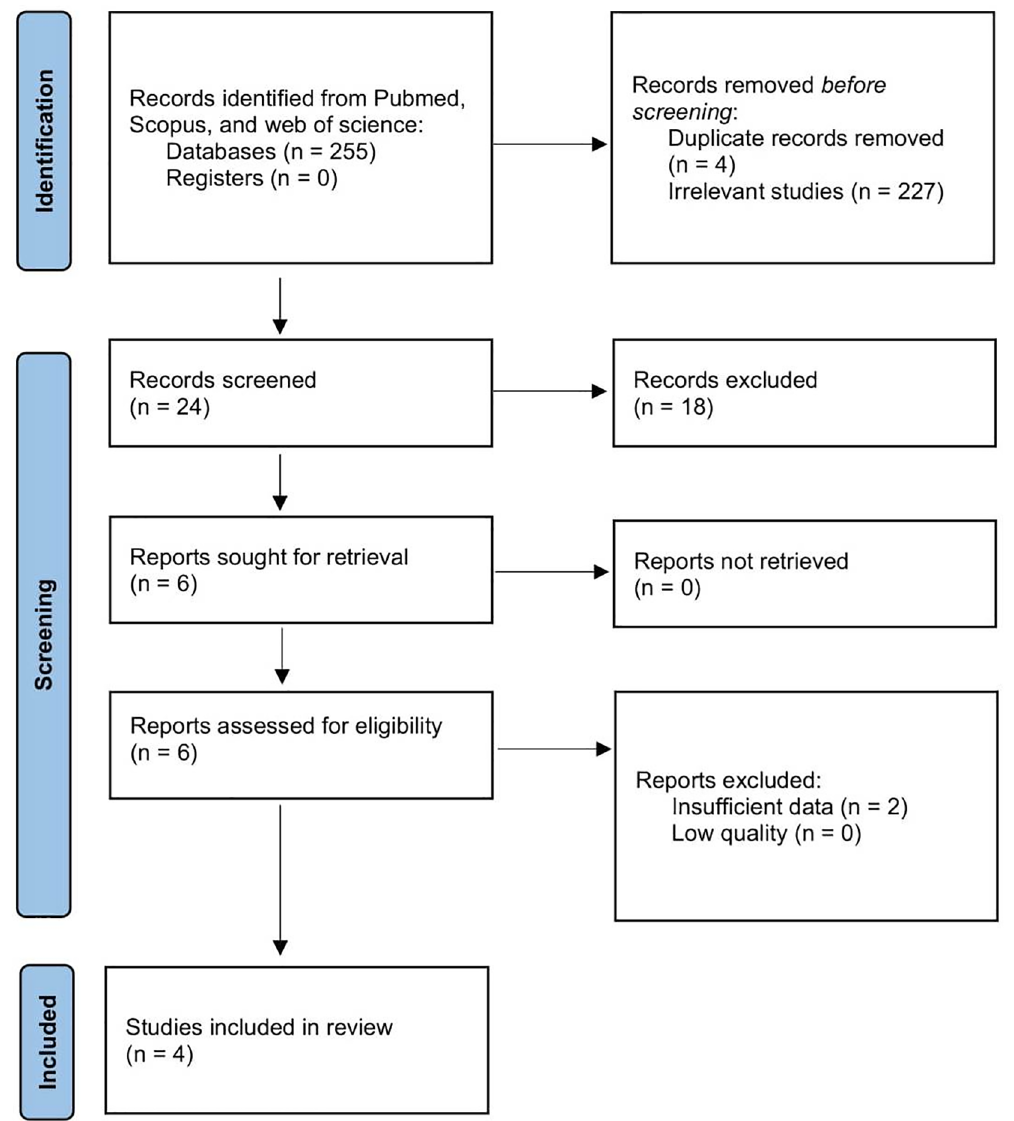
Figure 1. Preferred Reporting Items for Systematic Reviews and Meta-Analyses (PRISMA) flowchart of article selection in our